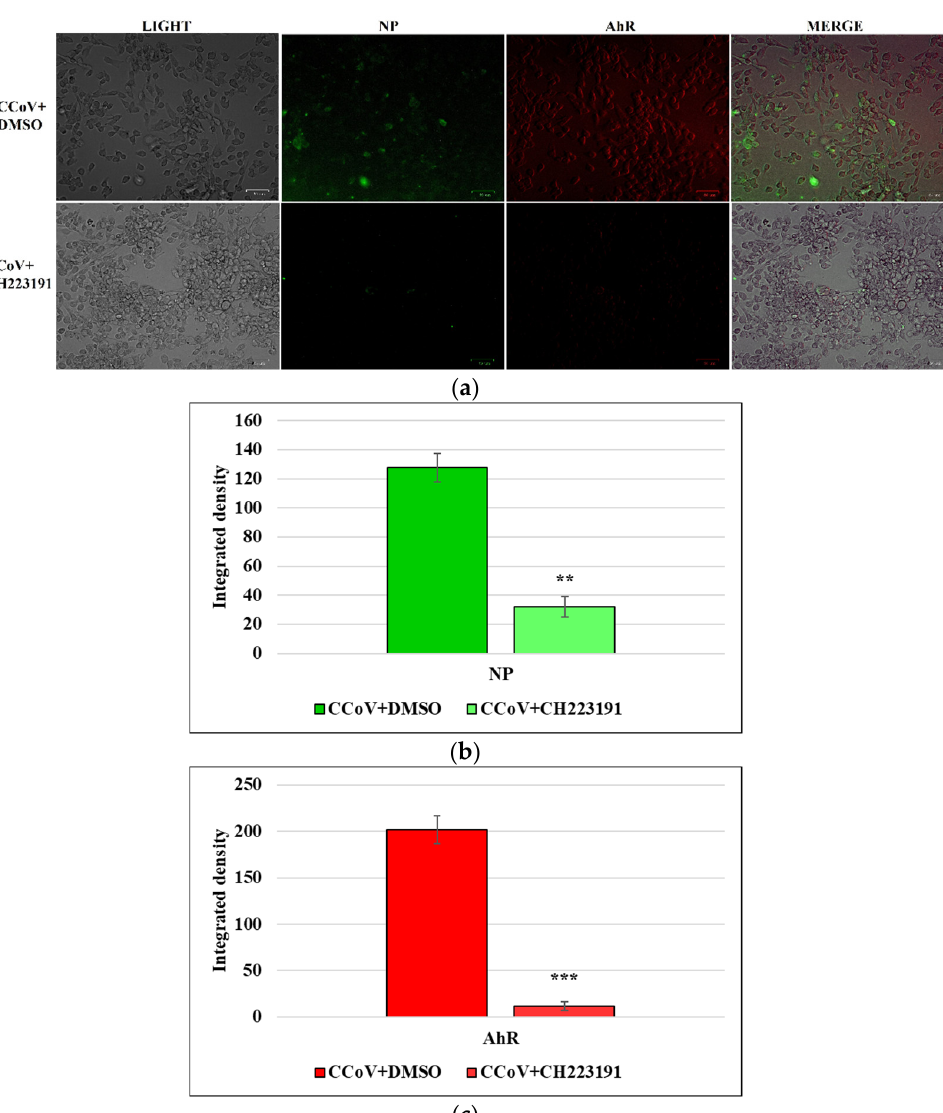
Figure 6. AhR inhibitor inhibits both AhR and NP expression during CCoV infection in A72 cells. A72 cells were infected with CCoV at MOI of 5. At 24 h p.i., immunofluorescence staining for AhR and NP was performed. ( a ) In CCoV-infected cells a significant up-regulation of AhR and NP expression was detected. In some merged images of A72 cells, co-expression of NP and AhR expression was found (MERGE). Following infection, in the presence of AhR inhibitor CH223191, both AhR and NP expression was down-regulated. Scale bar 59 μ m. ( b ) Bars represent the mean ratio generated from the integrated density (product of the area and mean intensity of fluorescence) of the NP expression during CCoV infection evaluated by ImageJ. Error bars represent standard deviation measurement. Significant differences between CCoV-infected cells and AhR-inhibitor-treated infected cells are indicated by probability p. ** p < 0.01. ( c ) Bars represent the mean ratio generated from the integrated density (product of the area and mean intensity of fluorescence) of the AhR expression during CCoV infection evaluated by ImageJ. Error bars represent standard deviation measurement. Significant differences between CCoV-infected cells and AhR-inhibitor-treated infected cells are indicated by probability p. *** p < 0.001.